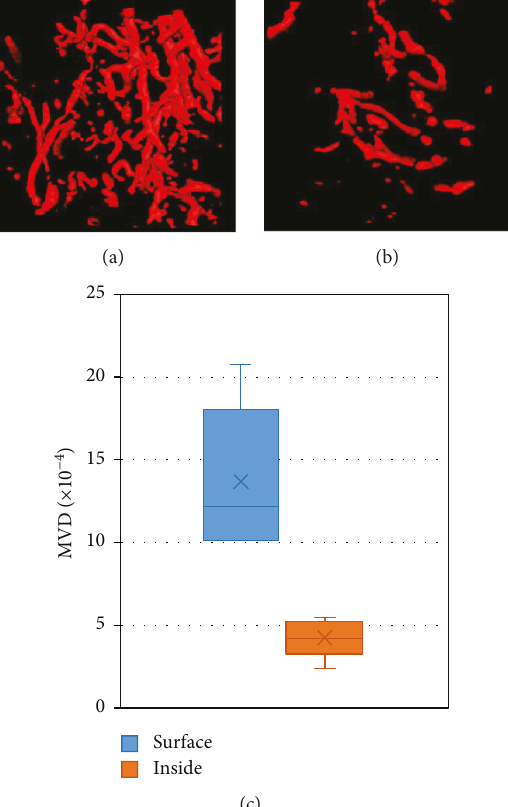
Figure 5: MVD comparison between the tumor surface and inside. (a) One VOI of tumor surface; (b) one VOI of tumor inside; (c) MVD of the two groups ( n = 10 per group).